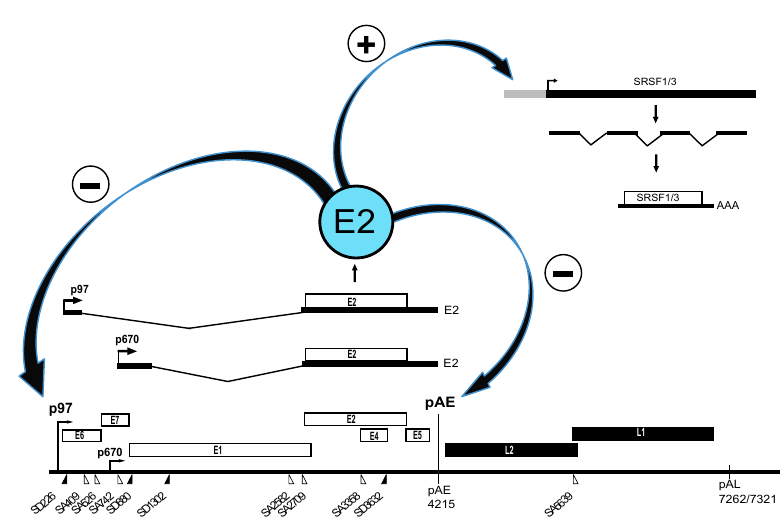
Figure 2. The HPV16 E2 proteins can be produced from two mRNAs generated either from the HPV16 early promoter p97, or the late promoter p670 [3]. These mRNAs are indicated above the schematic drawing of the HPV16 genome. The E2 protein affects HPV16 gene expression by inhibiting transcription from the HPV16 early promoter p97, which inhibits E6 and E7 expression [17], and by inhibiting the HPV16 early polyadenylation signal pAE, which promotes HPV16 late gene expression by inducing read-through into the HPV16 late region [22]. E2 could potentially also indirectly affect HPV16 RNA processing by activating expression of genes encoding serine/arginine rich (SR) proteins [23,24]. A direct induction of HPV16 late gene expression by E2 occurs when HPV16 affects the conformation of the polyadenylation complex that forms on pAE, thereby inhibiting pAE [22]. E2 therefore could function as a switch from HPV16 early gene expression to HPV16 late gene